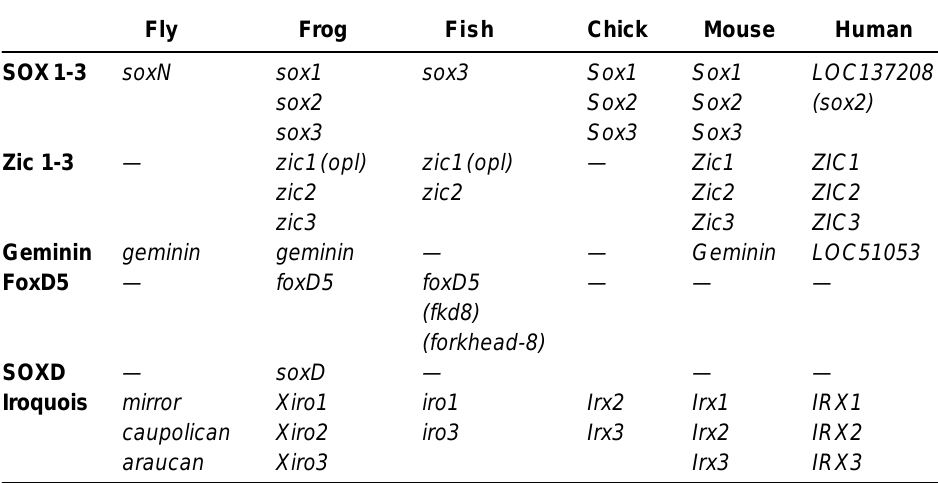
Names of Neural Fate-Stabilizing Genes Across